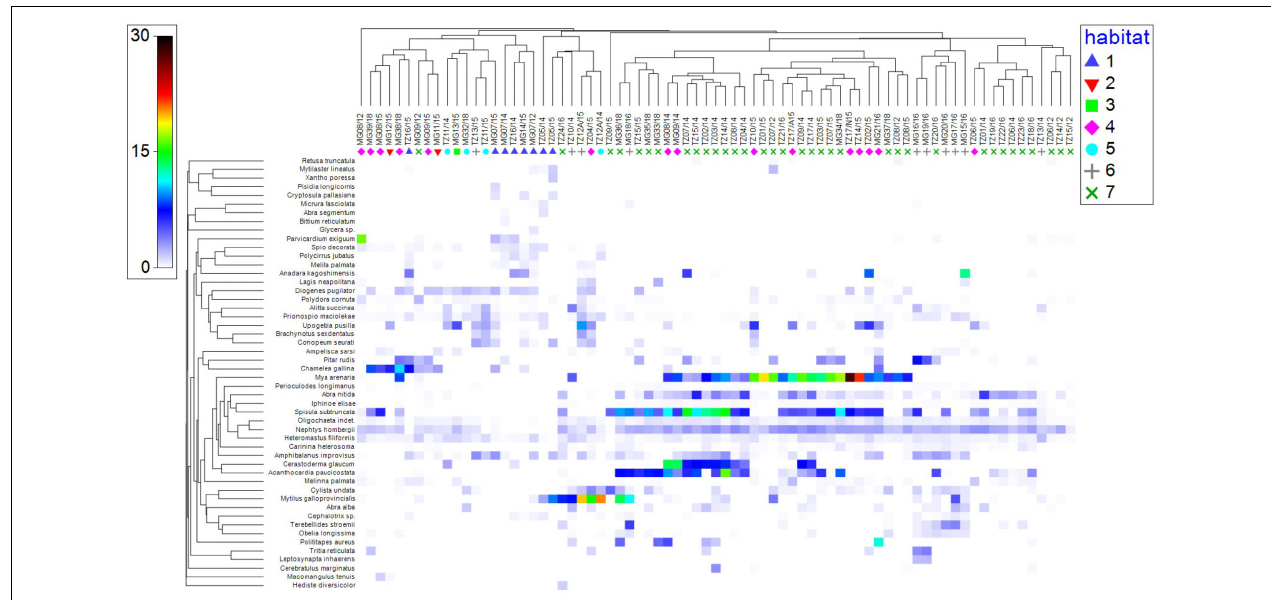
FIGURE 4 | Shade plot of square root transformed abundances for the 50 most abundant species. Species clustering based on index of association. Habitat codes as in Figure 3 . TABLE 2 | The main habitats described in the Cape Tuzla and the Mangalia Sulfur springs MPAs, according to the EUNIS classification (Davg, average density; Bavg, average biomass). Crt. no. Habitats Tuzla Mangalia Area, km